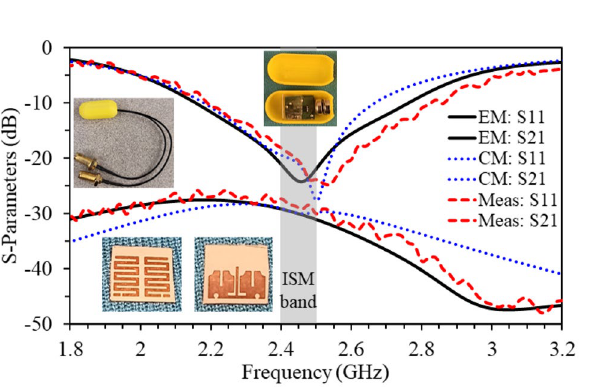
Figure 8. Fabricated antenna and its measurement setup for S-parameters and radiation patterns.